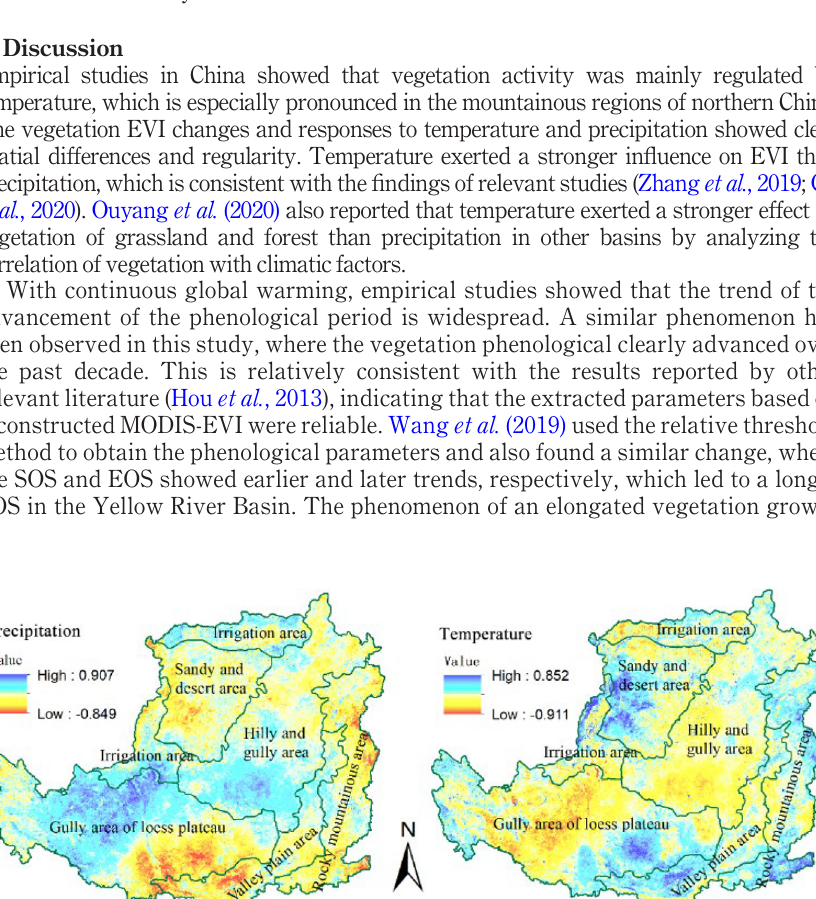
Figure 7. Partial correlation coef fi cients between EVI, precipitation and